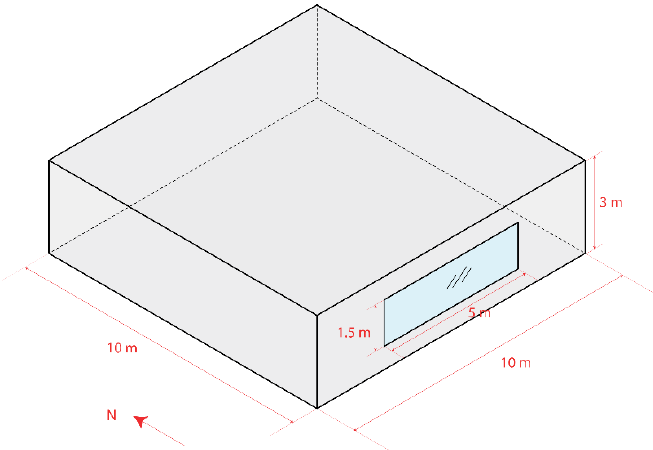
Figure 2. The shoebox model used for the control method.